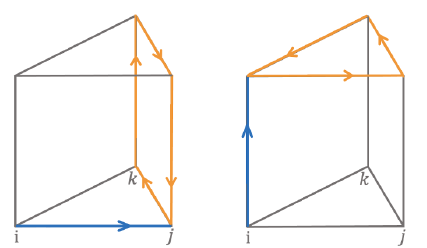
Figure 6. b ∪ db on each cube is a sum of two terms, assuming i < j < k in the branching structure. For each term, b on the blue link is multiplied to db around the orange plaquette, respecting the right-hand